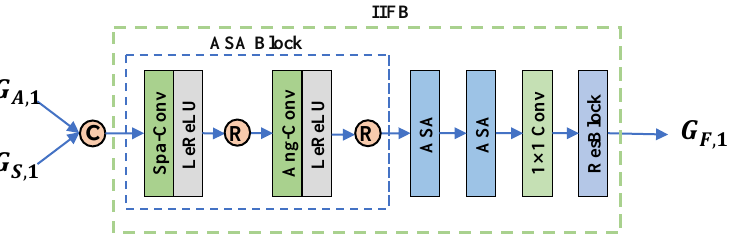
Figure 6. Detailed illustration of Interaction Information Fusion Block (IIFB). The main block in IIFB is ASA, which consists of Spa-Conv and Ang-Conv, closely stacked with a Leaky ReLU activation function, R represents the transpose